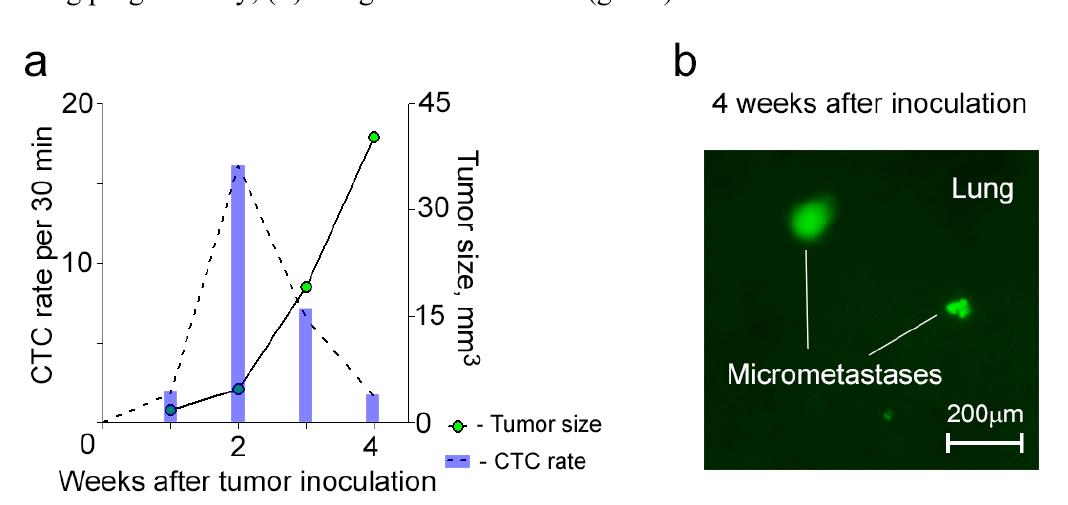
Figure 4. Dynamics of CTCs in mice after inoculation of CSCs. ( a ) A typical example of the dynamics of CTCs with their maximum number before the primary tumor starts growing progressively; ( b ) Lung micrometastases